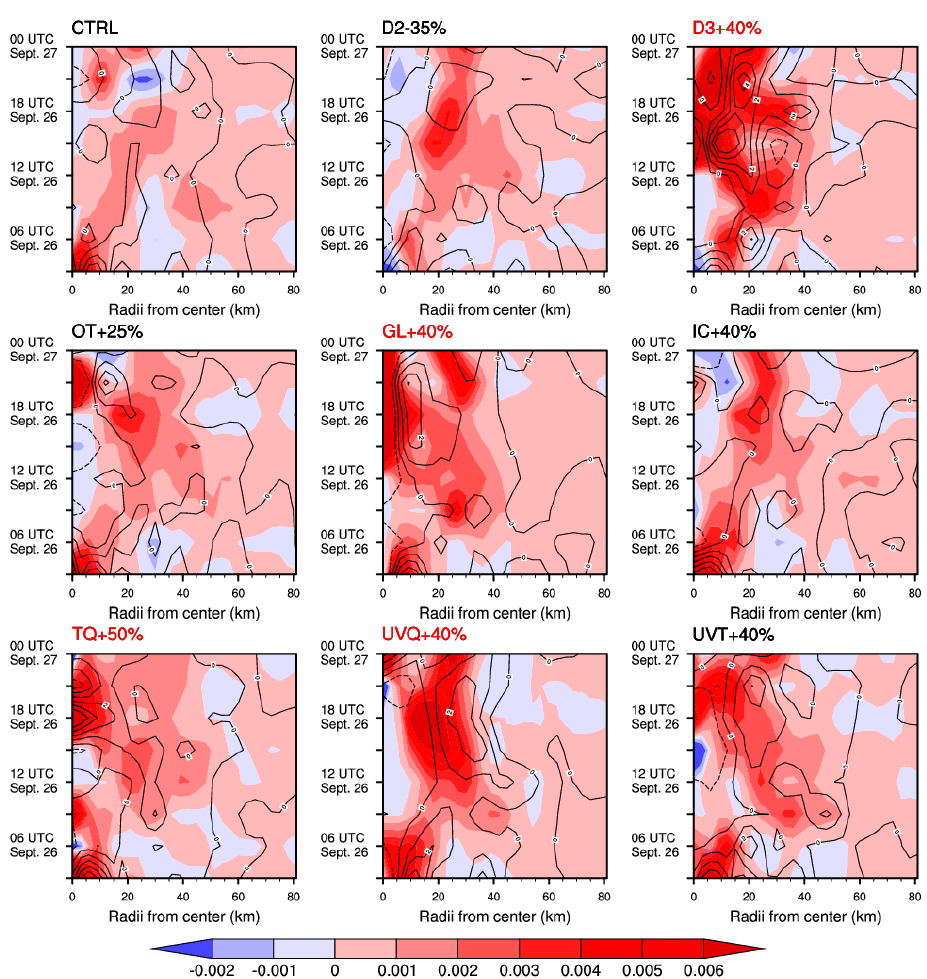
− 1 s − 1 ) and vertical velocity (contour; m s − 1